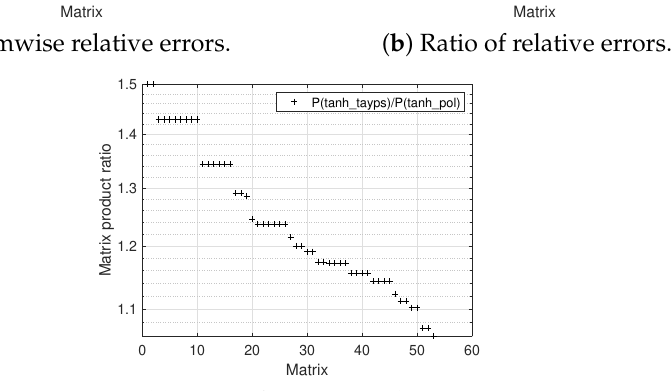
( c ) Ratio of matrix products. Figure 6. Experimental results for Test